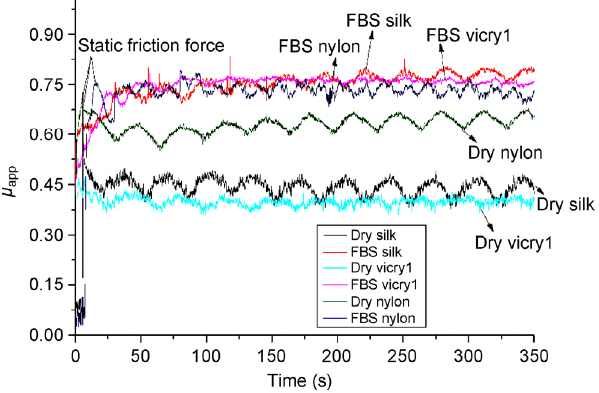
Fig. 11 The friction profile of surgical suture materials under 0.10 N applied load and 15 mm/s